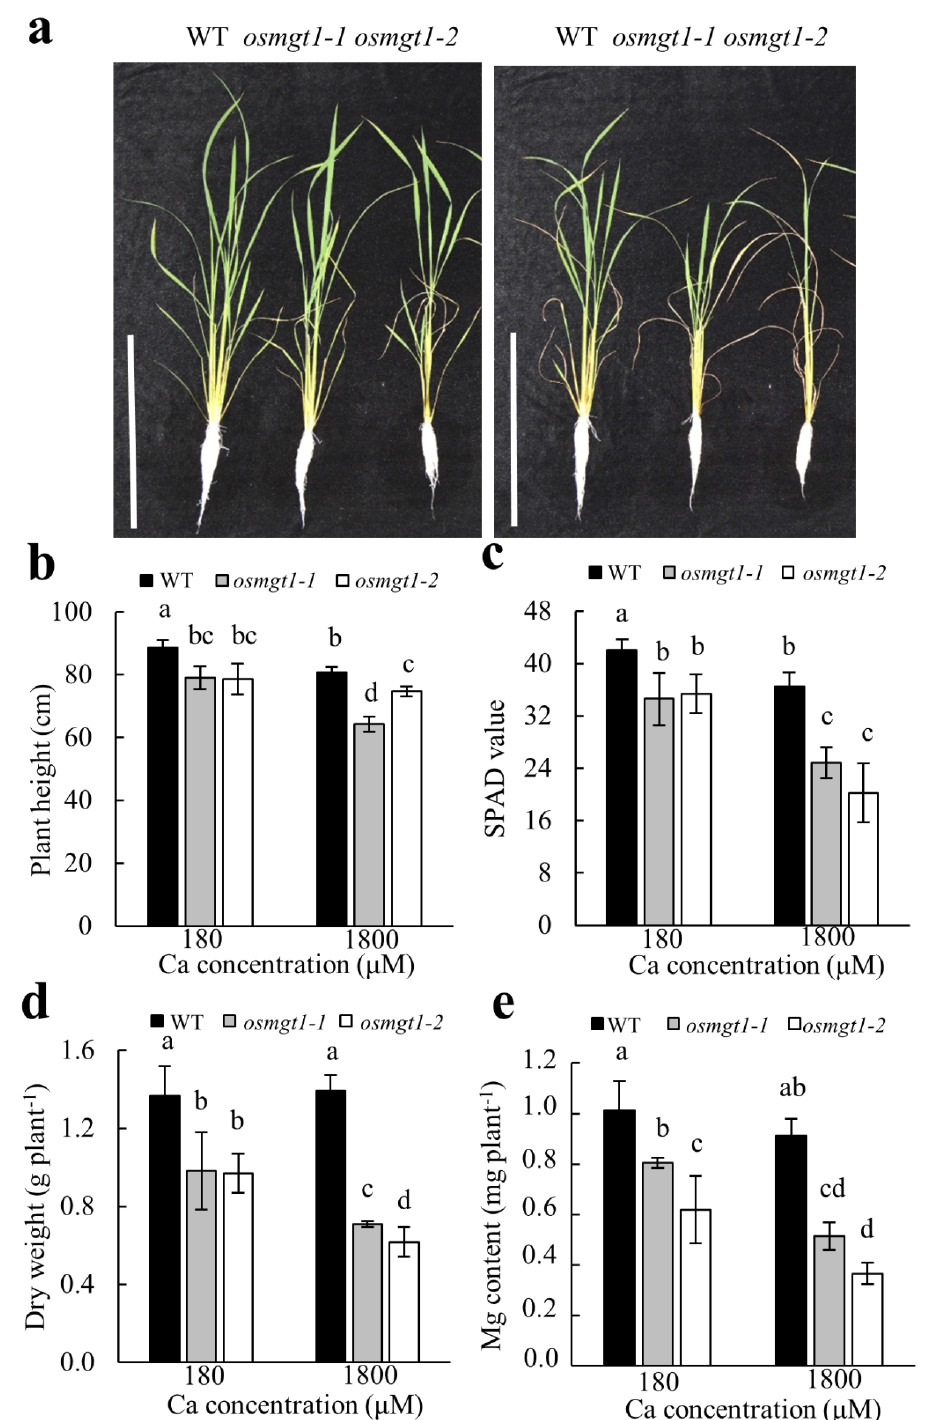
Figure 4. Aggravation of Mg deficiency by excessive Ca in OsMGT1 knockout lines. Seedlings of both WT and two OsMGT1 knockout lines were exposed to normal (180 μ M) or high (1800 μ M) Ca concentration in the presence of low Mg (10 μ M). Growth conditions ( a ). Left, 180 μ M; right, 1800 μ M ( a ). Plant height ( b ), SPAD value ( c ), dry weight ( d ) and Mg content ( e ). Data are means ± SD ( n = 3). Means with different letters are significantly different ( p ≤ 0.05 by Tukey’s test). Bar = 30